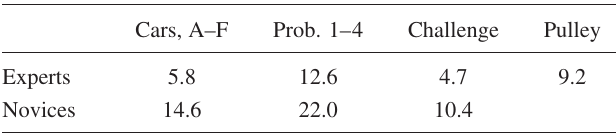
TABLE II. Average time (cid:1) in minutes (cid:2) for experts and novices to complete the interview tasks. “Cars, A–F” column shows the time to complete all groupings involving movies A–F. Note that the ex- perts produced 25% more car groupings than the novices on aver- age. “Prob. 1–4” refers to the first four electrostatics problems.